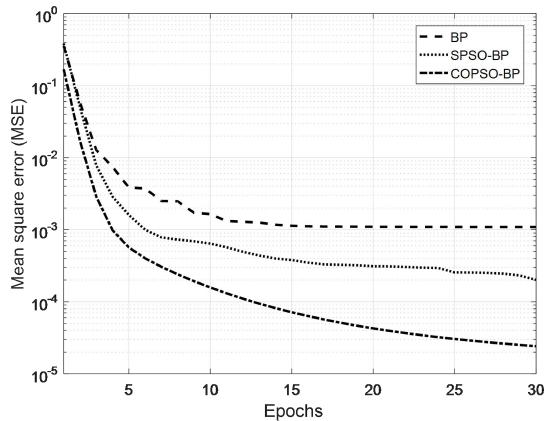
Figure 8. Comparison of mean square error